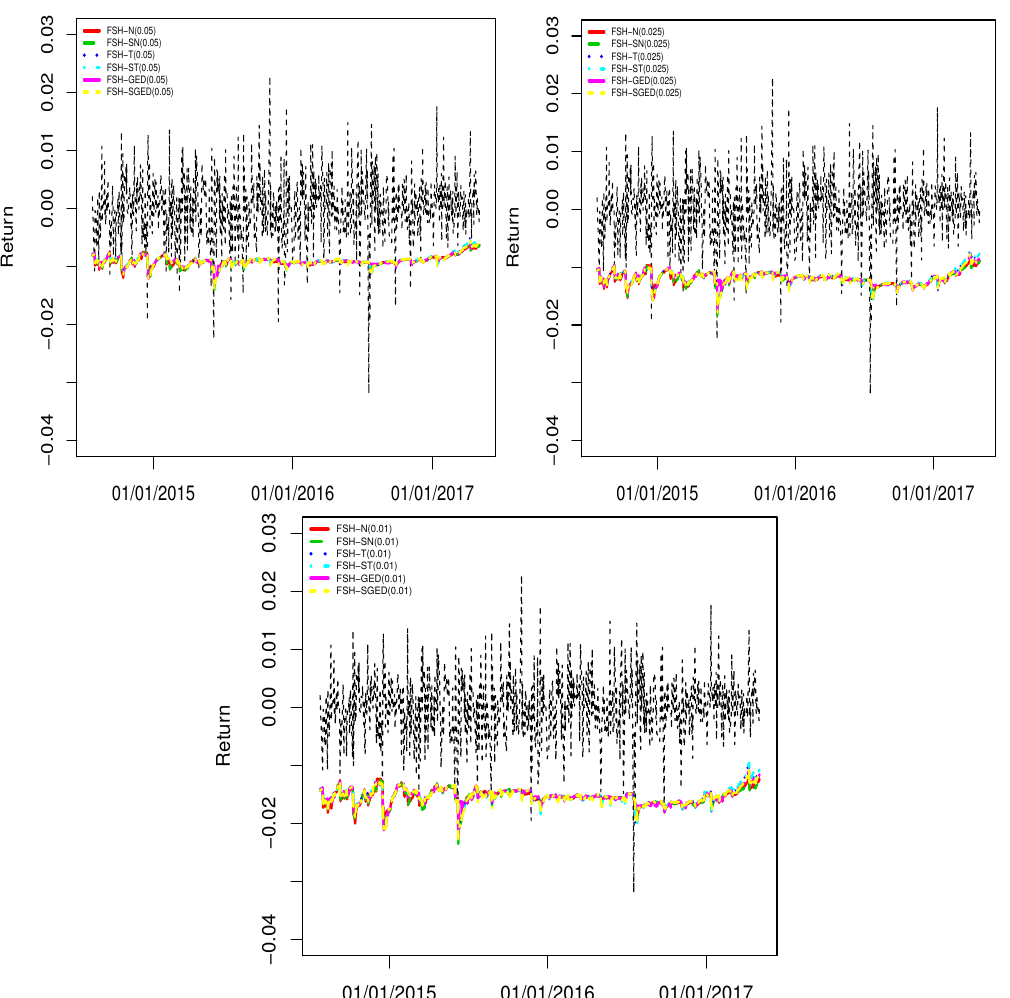
Figure 3. Daily VaR forecast of GARCH models with different innovation distributions for 97.5% and 99% confidence